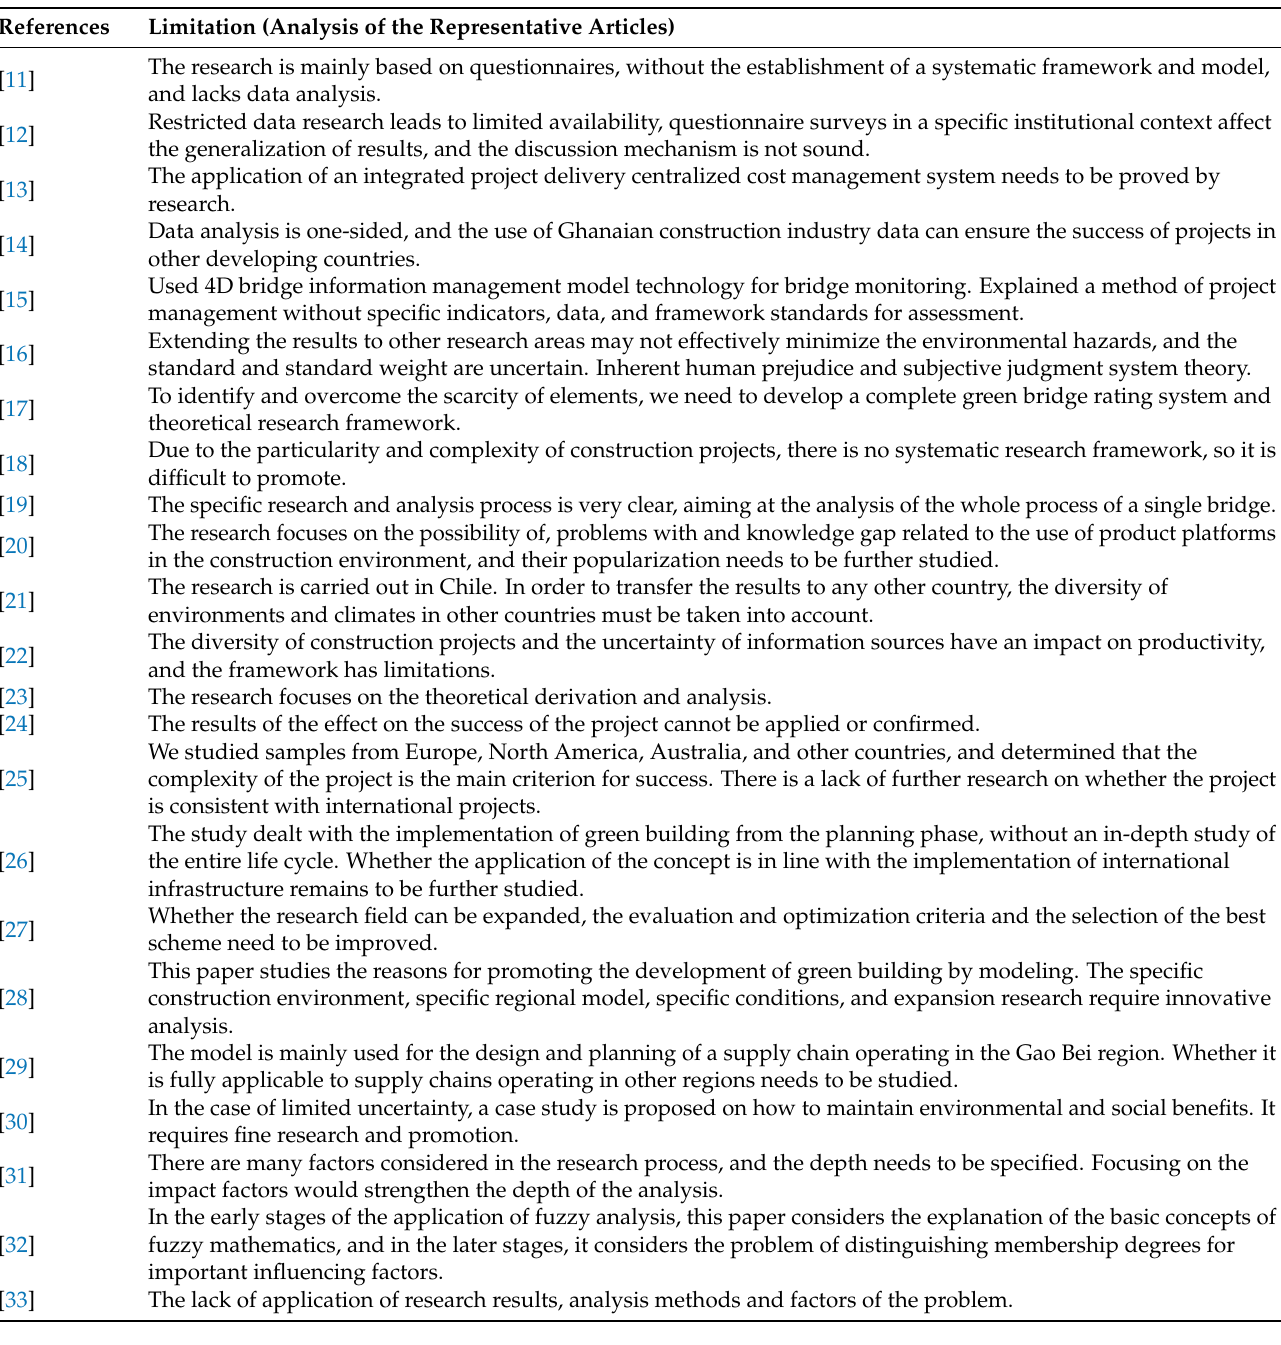
Table 1. Analysis and limitations of the highly relevant articles